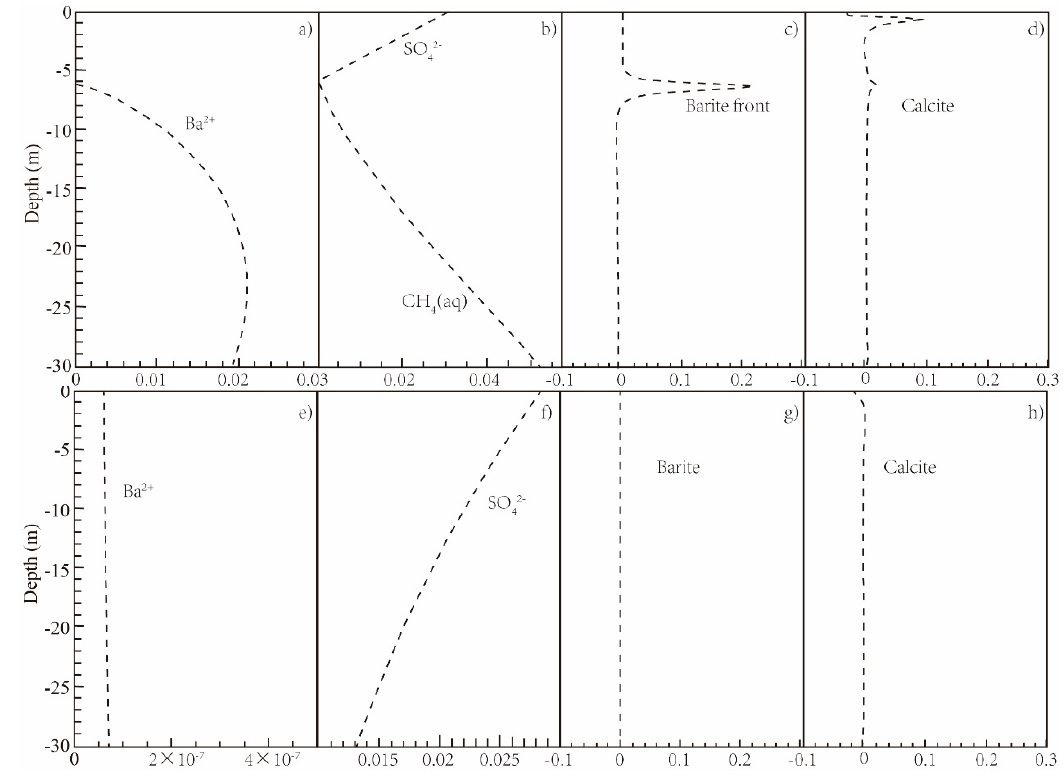
Figure 4. The simulation result of Base-case 1 ( a , b , c , d ) and Base-case 2 ( e , f , g , h ) at 100,000 years. ( a ) Concentration of barium. ( b ) Concentration of sulfate. ( c ) Volume fraction changes of barite. ( d ) Volume fraction changes of calcite. ( e ) Concentration of barium. ( f ) Concentration of sulfate. ( g ) Volume fraction changes of barite. ( h ) Volume fraction changes of calcite.